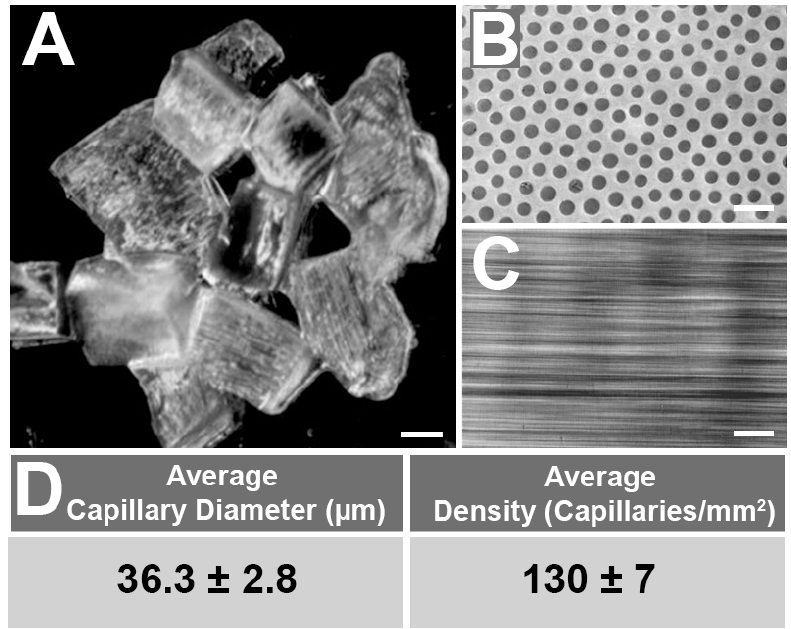
Figure 1. Capillary alginate hydrogel (Capgel) biomaterial tissue scaffolds have uniform microstruc- tures of parallel, patent, regular tubular microchannels. ( A ) Gross stereomicrograph of cut Capgel pieces used to load syringe barrels. Phase-contrast micrographs of Capgel ( B ) imaged parallel to and ( C ) perpendicular to the capillary microstructure; ( D ) average capillary diameter and density of Capgel used in this study ± standard deviation (SD). Scale bar = 1 mm for ( A ) and 100 µ m for ( B , C